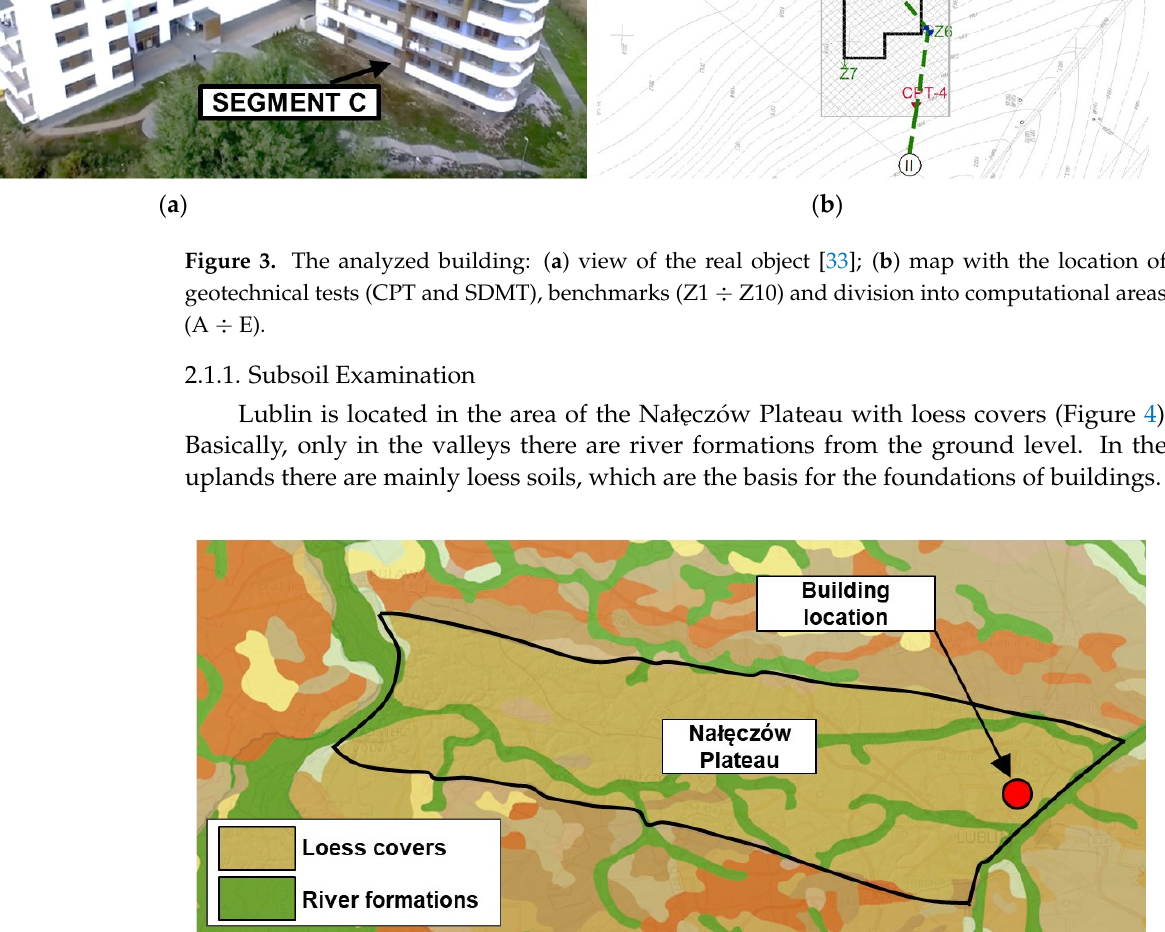
Figure 4. A geological map of the research area.